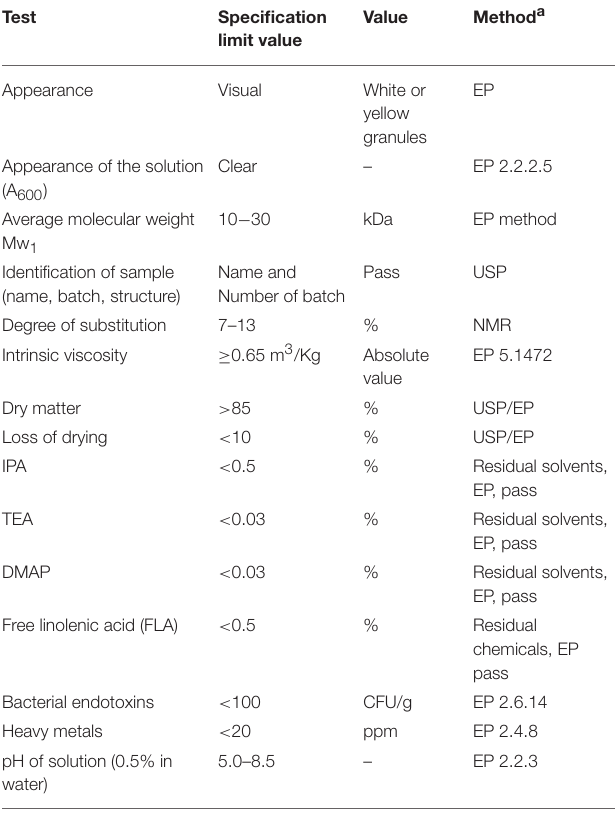
TABLE 3 | Sodium linolenyl hyaluronate and its specification; the table provides the identity of each batch, acceptance criteria, and analytical methods used for the test (Huerta-Angeles et al.,